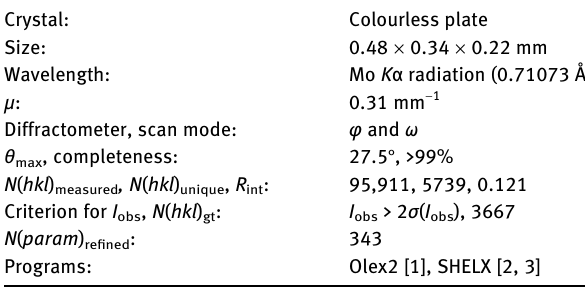
Table  : Data collection and handling.